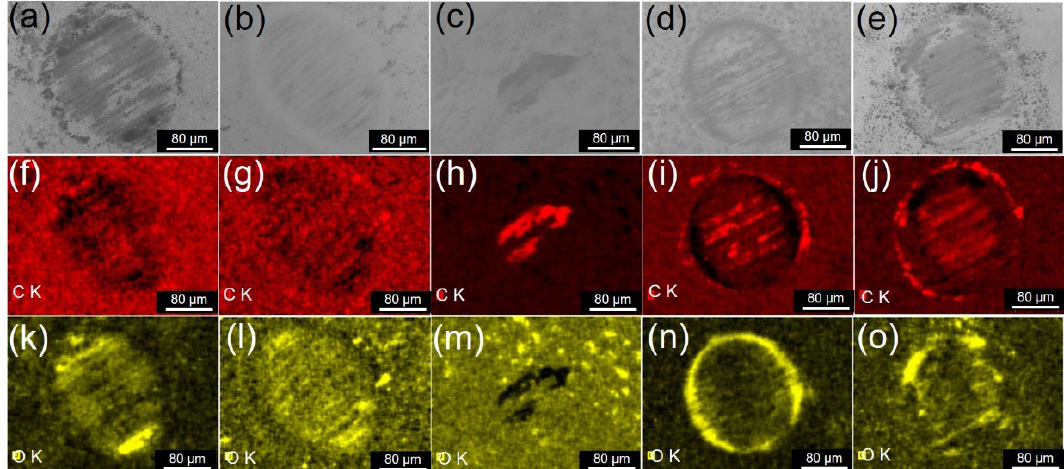
Fig. 6 SEM micrographs and EDS maps of the wear scars of cemented carbide balls under a load of 8 N: the wear scars sliding against non-impregnated graphite at 20 °C (a, f, k) and 160 °C (b, g, l); the scars sliding against impregnated graphite at 20 °C (c, h, m), 100 °C (d, i, n), and 160 °C (e, j,